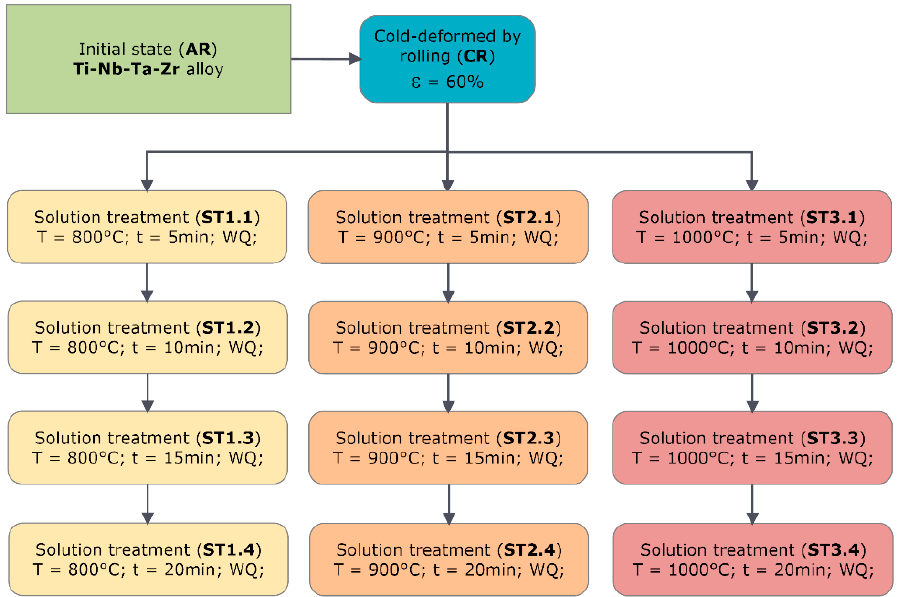
Figure 1. Thermo-mechanical processing scheme applied to Ti-Nb-Ta-Zr alloy (Ti-25.5Nb-4.5Ta- 8.0Zr wt%).